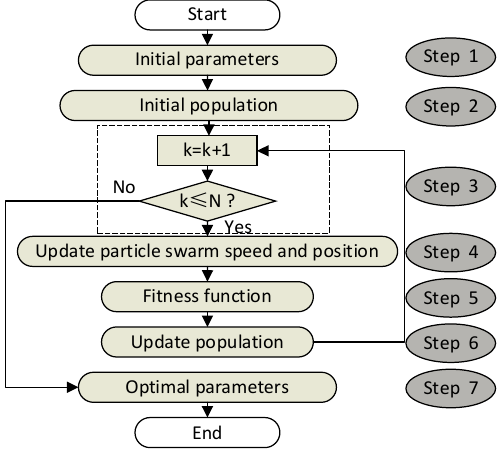
Figure 6. Flowchart of the optimization procedure.